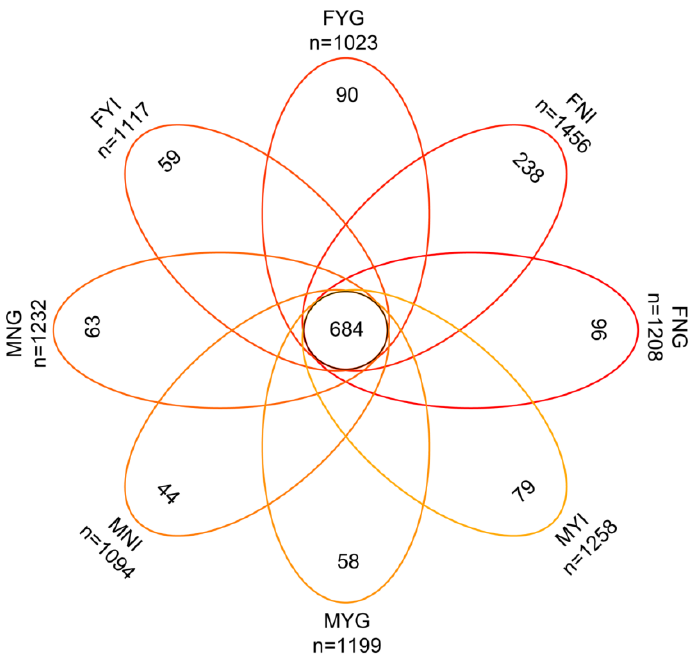
Figure 3. Microbial diversity indices in the intestine and gill microbial samples of dwarf-form populations of Sthenoteuthis oualaniensis . ( a ) Observed, ( b ) Chao1 indices, ( c ) Simpson indices, and ( d ) Shannon indices. FNI: intestine samples of females with immature gonads, MNI: intestine samples of males with immature gonads, FYI: intestine samples of females at sexual maturity, MYI: intestine samples of males at sexual maturity; FNG: gill samples of females with immature gonads, MNG: gill samples of males with immature gonads, FYG: gill samples of females at sexual maturity, and MYG: gill samples of males at sexual maturity. * Indicates the significant difference between two samples ( p < 0.05) and ** indicates the extremely significant difference between two samples ( p < 0.01).